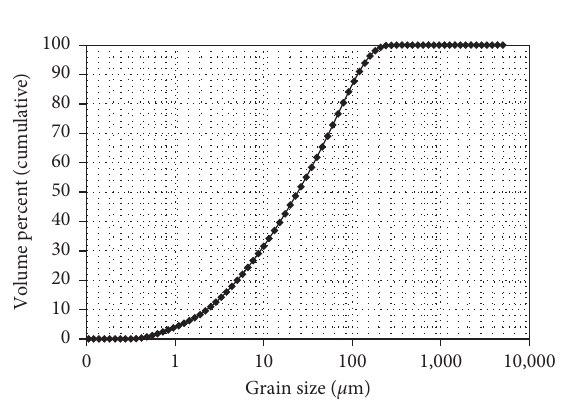
Figure 2: Particle size distribution of tailings.